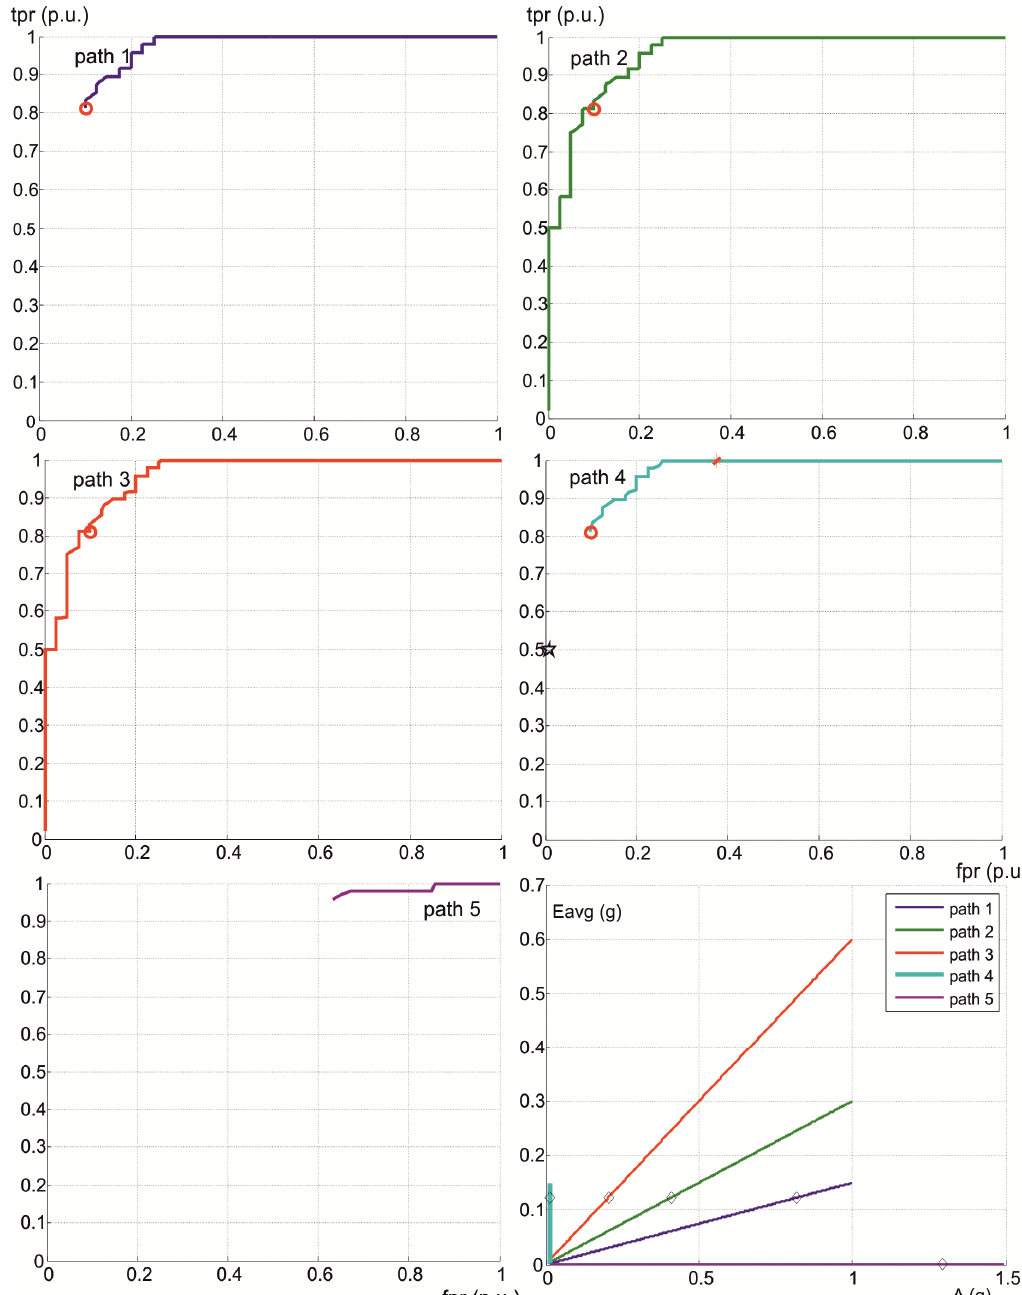
Figure 7. ROC curves associated with the paths of thresholds A–E in the parameter’s space, for the personalized isotropic algorithm with 4 axes. Diamond points in the parameter space refer to threshold values, where the associated ROC curve quits the tpr = 1 line. Red circles on the ROC curves correspond to E = 0.15 g ( E parameter’s space